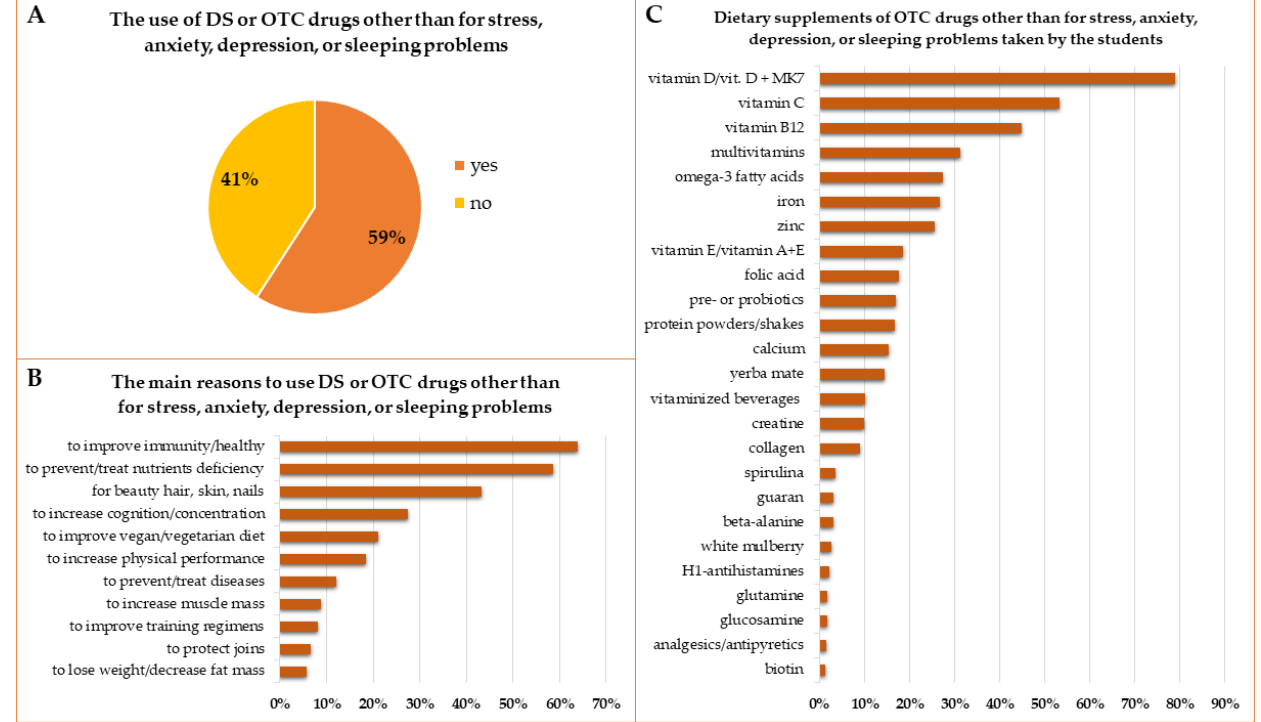
Figure 7. The general use of dietary supplements or OTC drugs other than for stress, anxiety, depression, or sleeping problems in the academic year 2020/2021 ( A ), the main reasons to take this kind of DS or OTC drugs ( B ), and DS or OTC drugs other than for stress, anxiety, depression, or sleeping problems that were the most commonly chosen by the students (MK7—menaquinone-7) ( C ). The genus and species names of herbs from Figure 7C are as follows (in the order from the most frequently used): Ilex paraguariensis A.St.-Hil. (yerba mate), Paullinia cupana Kunth (guarana), and Morus alba L. (white mullberry) . Table 4. The use of dietary supplements OTHER than for stress, anxiety, depression, or sleeping problems among Wroclaw Medical University students in the academic year 2020/2021. Analyses were performed using the chi-square test.